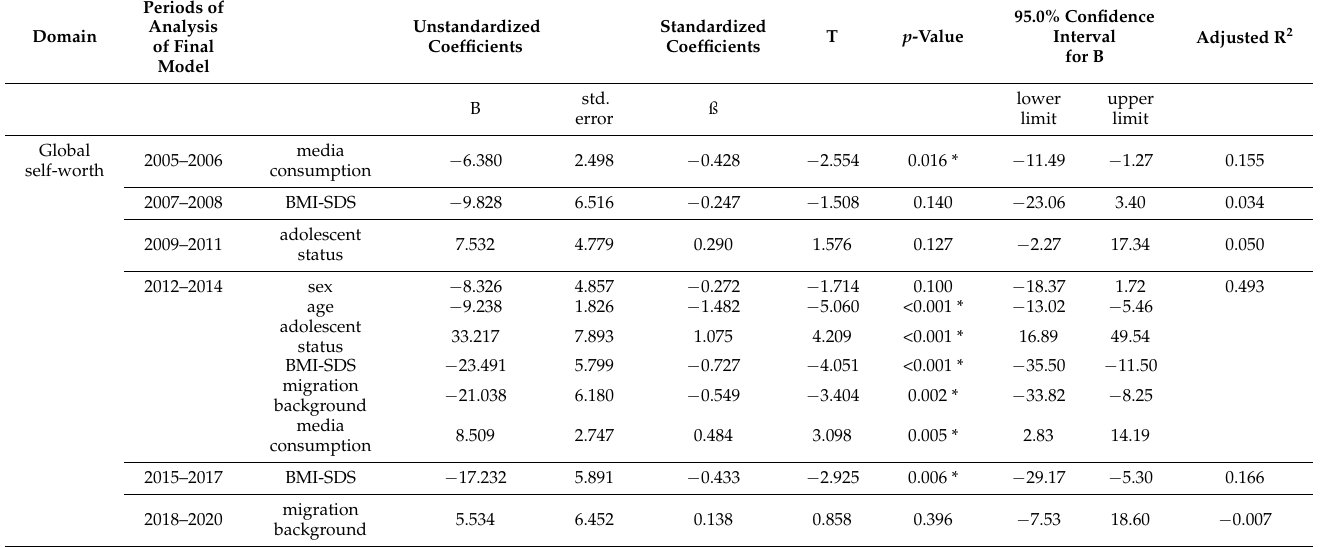
Table 7. Linear regression analysis (backward) of the global self-worth domain.